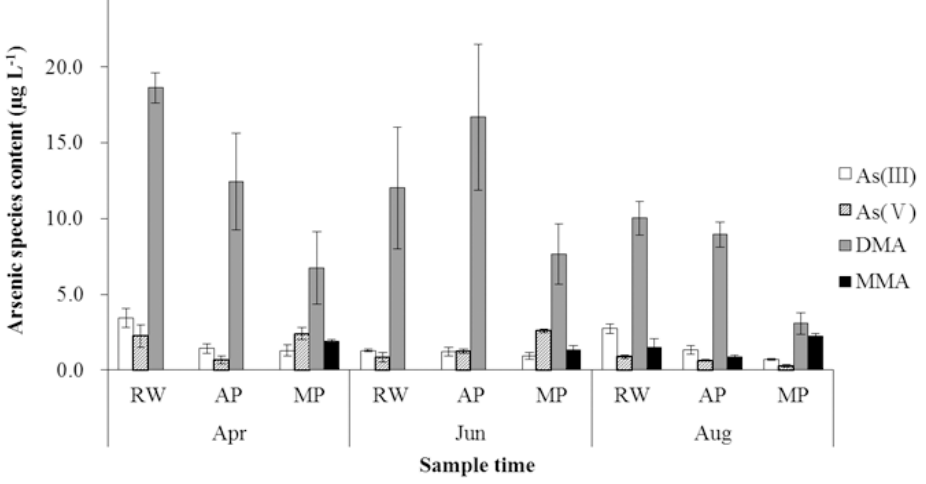
Figure 1. Dissolved (<0.45 μ m) concentrations of different As species in the swine wastewater samples of raw wastewater (RW), acidogenic phase (AP) and methanogenic phase (MP) in different months.